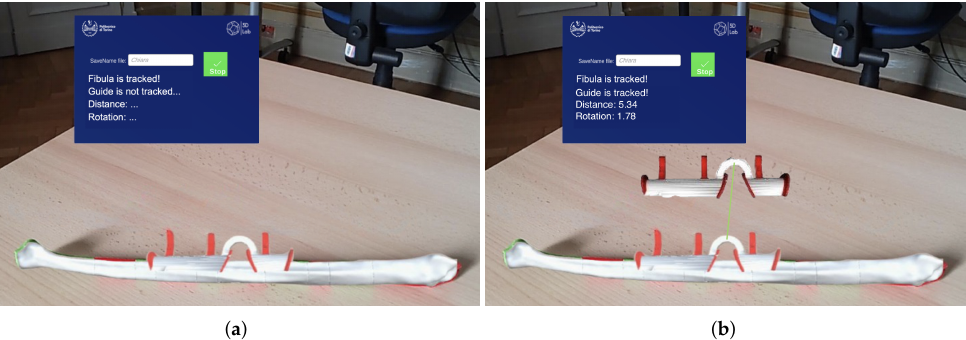
Figure 5. Example of fibula tracking. ( a ) When the fibula is detected, its virtual model (white colored) appears superimposed on it along with the surgical guide in the correct position, as determined by the medical team before the procedure. ( b ) The real surgical guide is tracked during its positioning by our system, providing feedback about its current distance both in position, both in rotation, from its correct